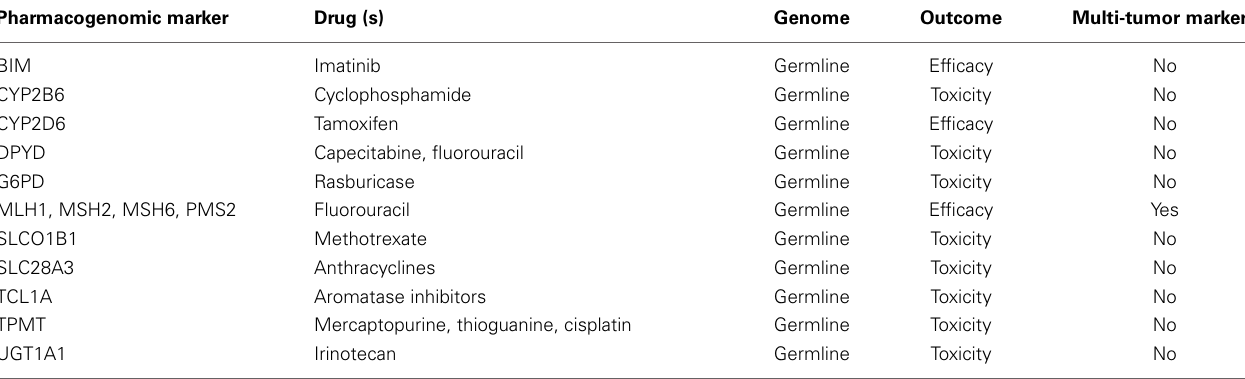
Table 2 | Selected germline pharmacogenomic